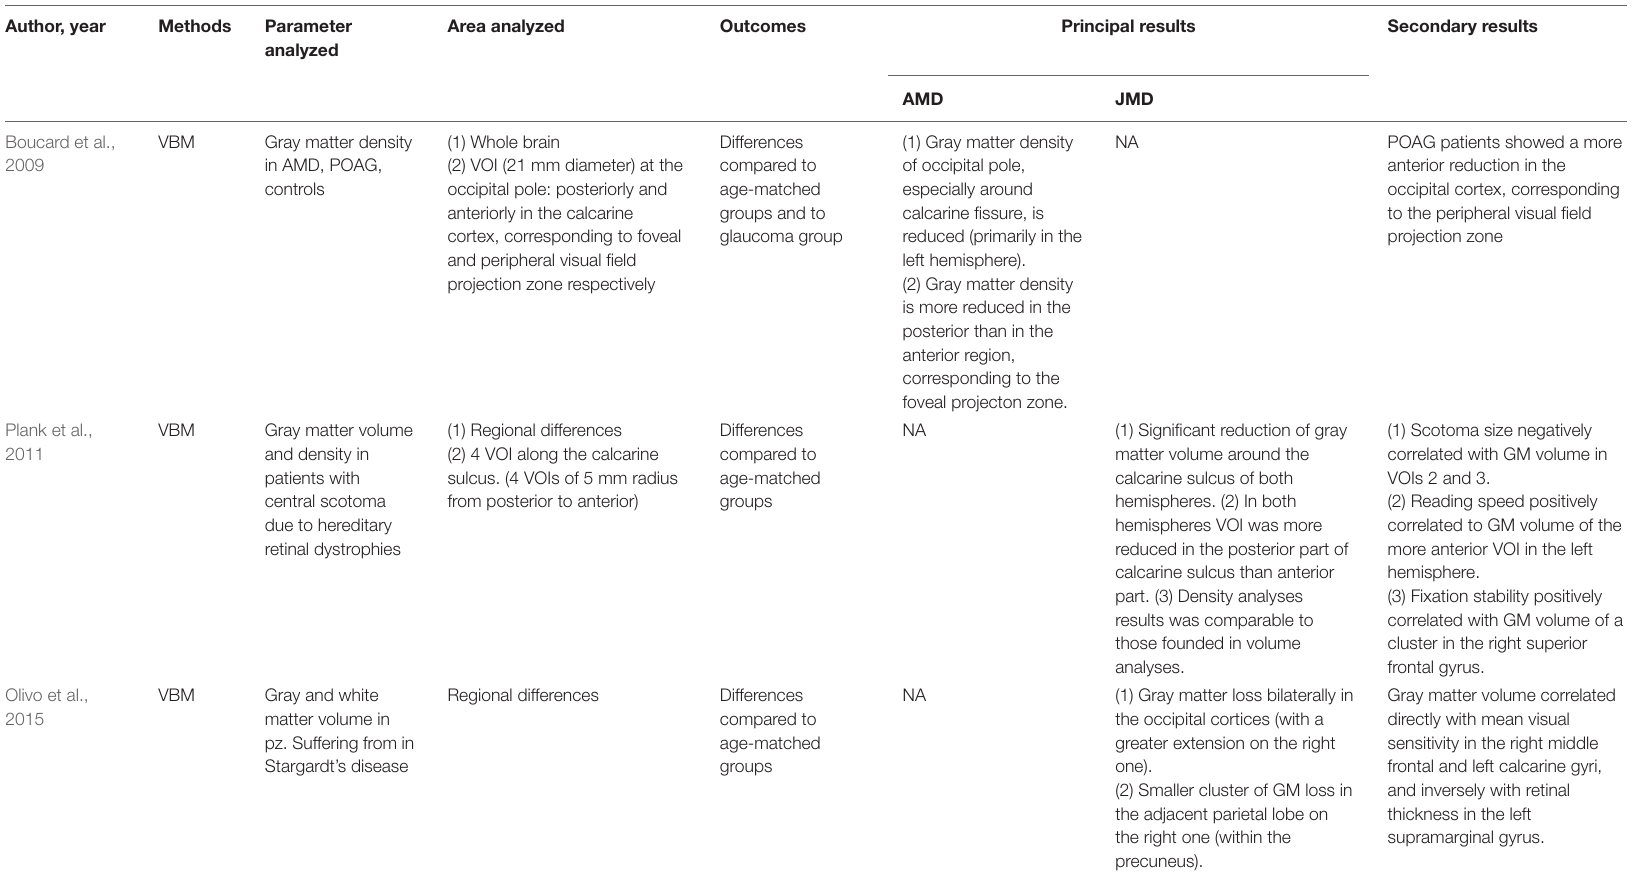
TABLE 2 | Outcomes of structural